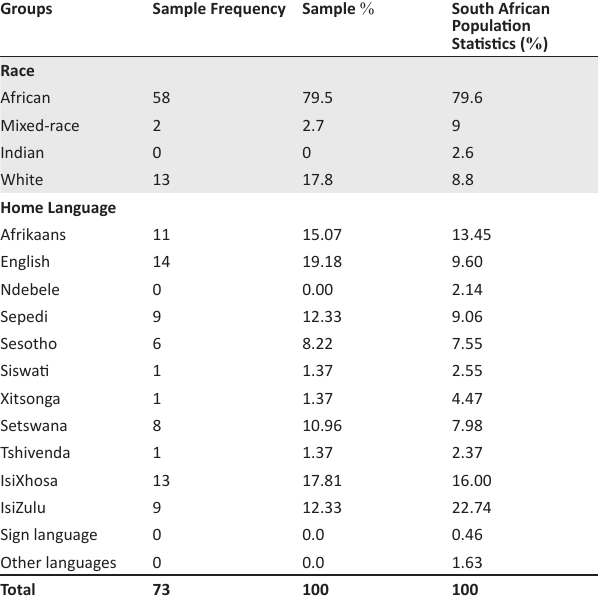
TABLE 1: Race distribution of the sample group.